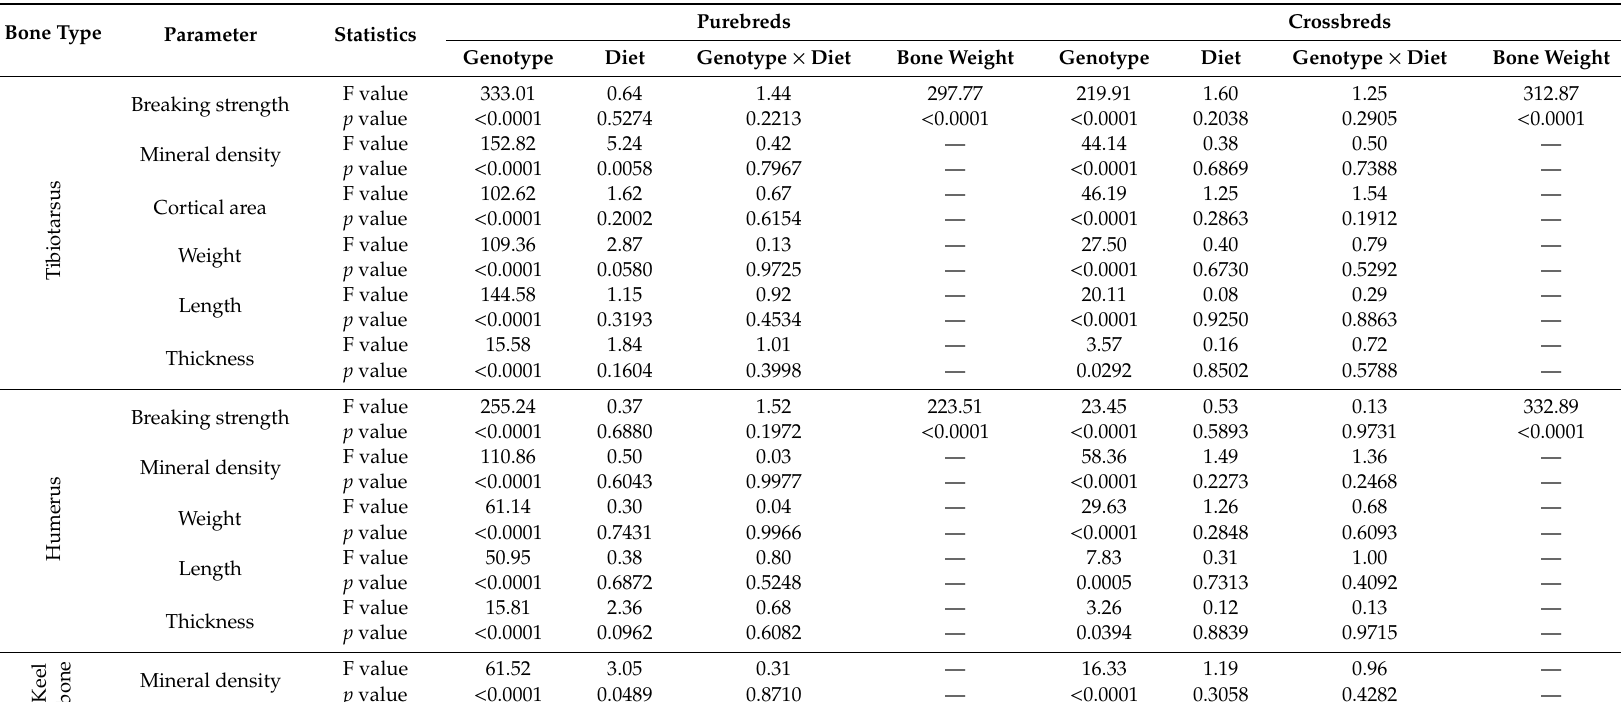
Table 5. E ff ect of genotype, diet and their interaction on bone characteristics of tibiotarsus, humerus and keel